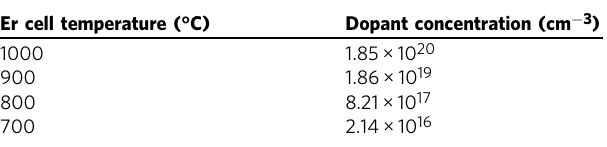
Table 1 Relation between the dopant concentration and Er cell temperature calibrated using secondary ion mass spectroscopy